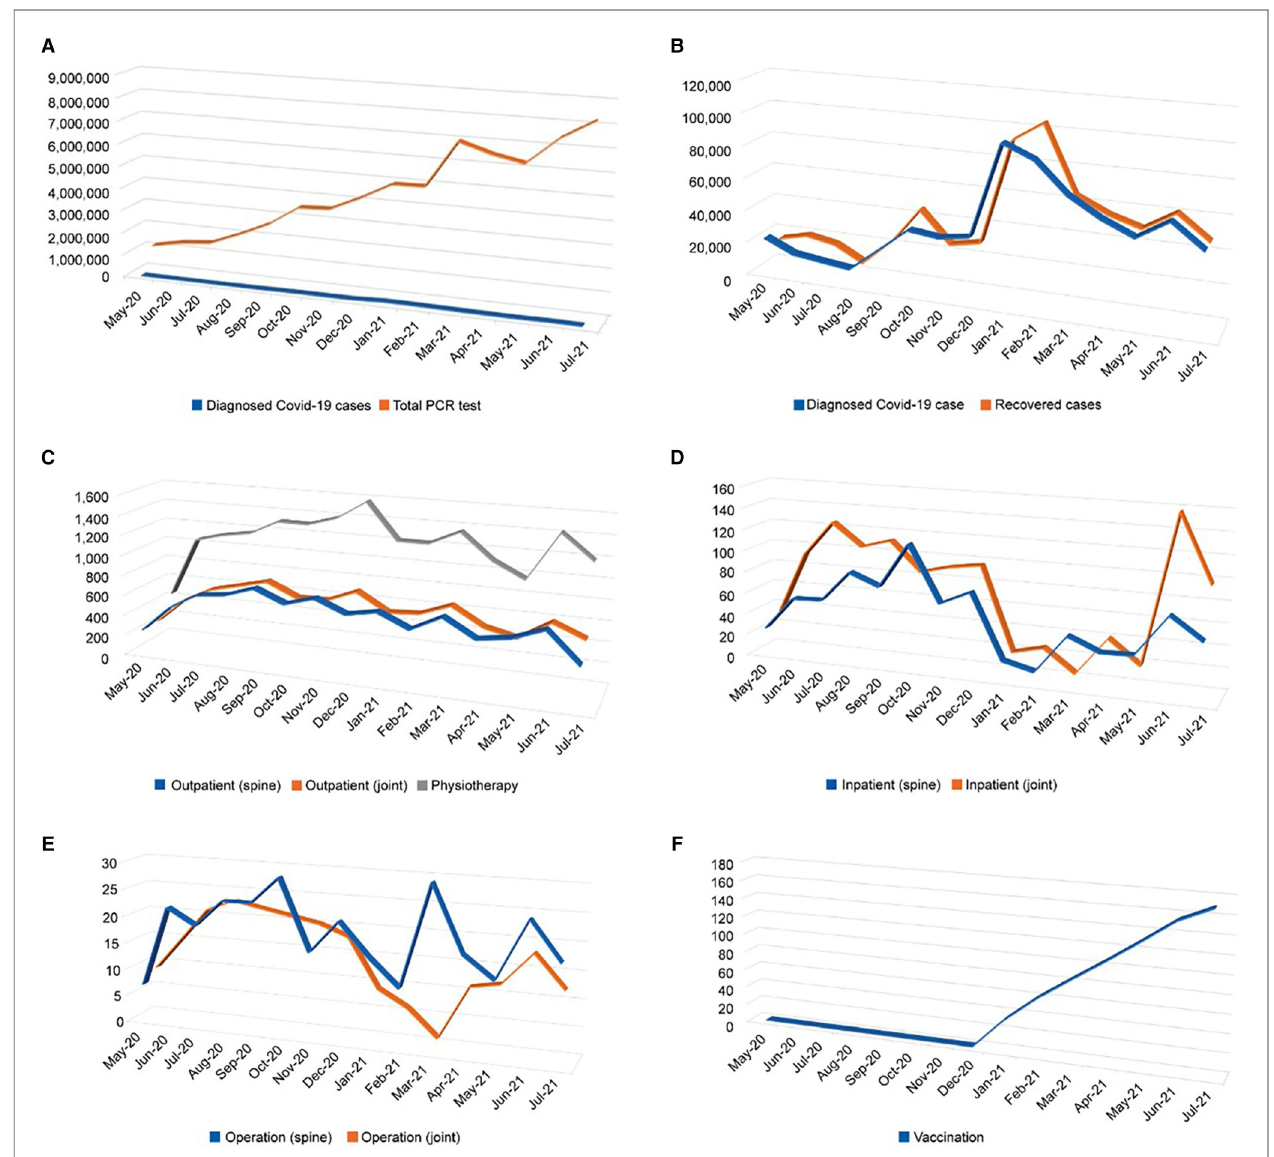
FIGURE 1 | Graphs of national data of coronavirus disease 2019 (COVID-19) and hospital visiting patterns. ( A ) Diagnosed cases and number of polymerase chain reaction (PCR) tests; ( B ) Diagnosed and recovered cases; ( C ) Outpatient count in each department; ( D ) Inpatient count in each department; ( E ) Operation count in each department; ( F ) Vaccination